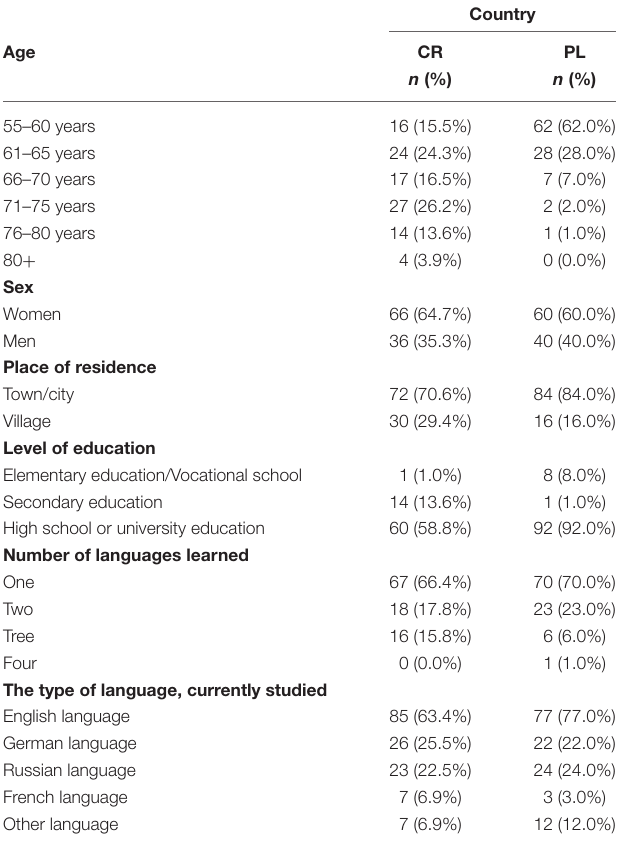
TABLE 1 | Demographic characteristics of the Czech and Polish respondents.